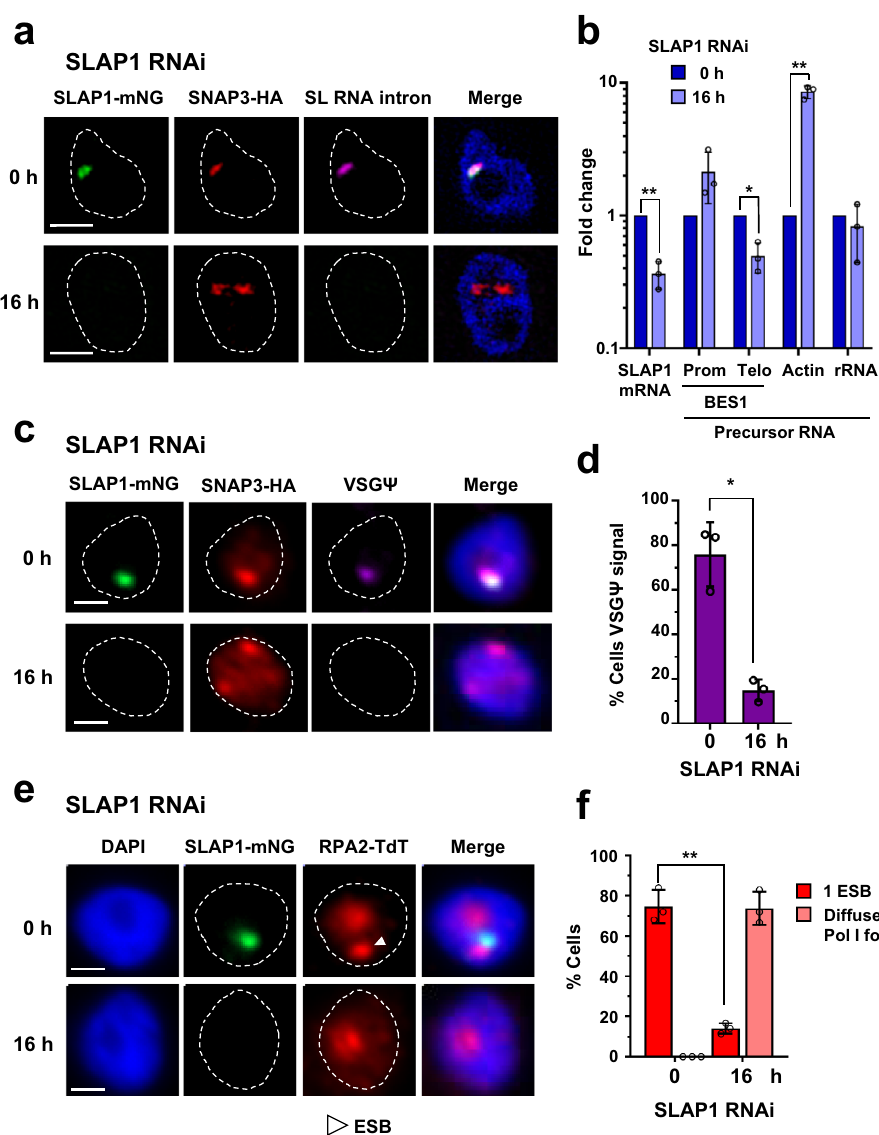
Fig. 3 SLAP1 regulates SL-RNA production with knockdown resulting in an ES transcription block. a SR-SIM imaging of a BF T. brucei cell line with nuclear signals corresponding to mNG::SLAP1 (SLAP1 mNG, green) or SNAP3::6xHA (SNAP3-HA, red), with the SL-RNA intron (magenta) visualised with RNA-FISH. SLAP1 RNAi was induced for the time in hours (h). b ) RNA quantitation using qPCR from cells in ( a ) after induction of SLAP1 RNAi for the time in hours (h). Nascent RNA is from the promoter (Prom) or telomere (Telo) of BES1, or from the actin or rRNA loci. Average values are from three biological replicates with error bars indicating ± SD. ** P ≤ 0.01; * P ≤ 0.05. For SLAP1 mRNA, P = 0.006, BES1 telomere pre-mRNA P = 0.02 and actin pre-mRNA P = 0.0051. c Fluorescence microscopy imaging of a BF T. brucei cell line, with mNG::SLAP1 (SLAP1 mNG, green) and SNAP3::6xHA (SNAP3-HA, red) signal shown, with VSG Ψ transcript (magenta) detected with RNA-FISH. SLAP1 RNAi was induced for the time in hours (h). d Quantitation of the percentage (%) of cells in ( c ) with VSG Ψ RNA-FISH signal after induction of SLAP1 RNAi for the time in hours (h). Values are the average of three biological replicates, with error bars indicating± SD. At least 297 1K1N cells were counted for each condition. * P = 0.029. e Fluorescence microscopy imaging of a BF T. brucei cell line with a signal corresponding to mNG::SLAP1 (SLAP1-mNG, green) or TdT::RPA2 (RPA2-TdT, red), and a white arrowhead indicating the ESB. SLAP1 RNAi was induced for the time in hours (h). f Quantitation of the percentage (%) of cells in ( e ) with a discrete ESB after induction of SLAP1 RNAi for the time indicated in hours (h). Averages of three biological replicates are shown, with error bars indicating ± SD. At least 247 1K1N cells were counted for each condition. ** P = 0.0031. In all microscopy images nuclei (dashed lines) are stained with DAPI (blue). On bar graphs, the values from individual replicates are shown with circles. All P values were determined using a two-tailed paired Student ’ s t test. All scale bars = 1 µ m. Source data are provided as a Source Data fi